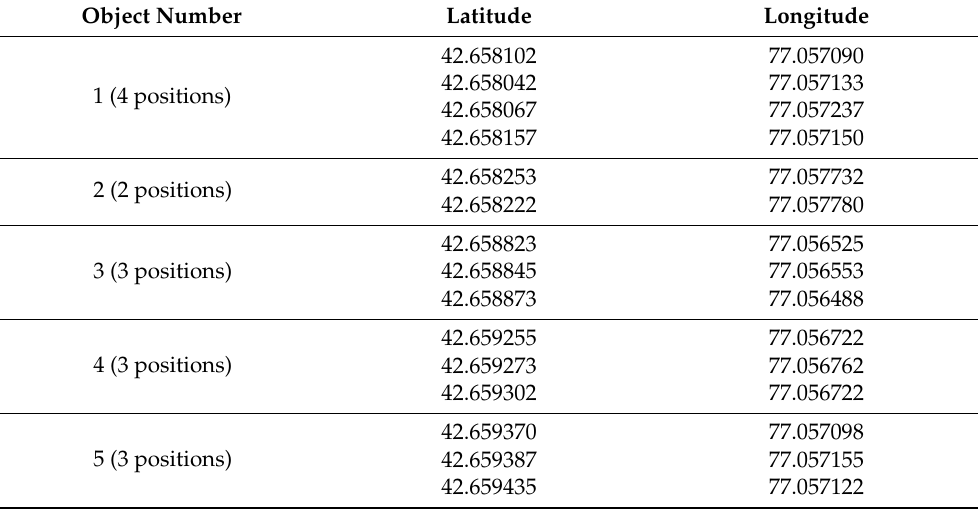
Table 2. GPS scanner positions while obtaining petroglyph data.